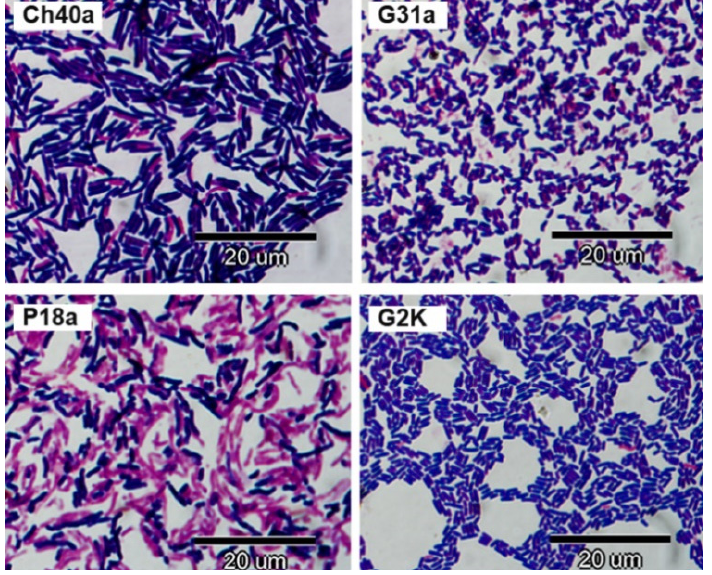
Figure 3. Gram staining results for selected avian L. salivarius strains from chicken (Ch40a), geese (G31a, G2K) and pigeon (P18a).